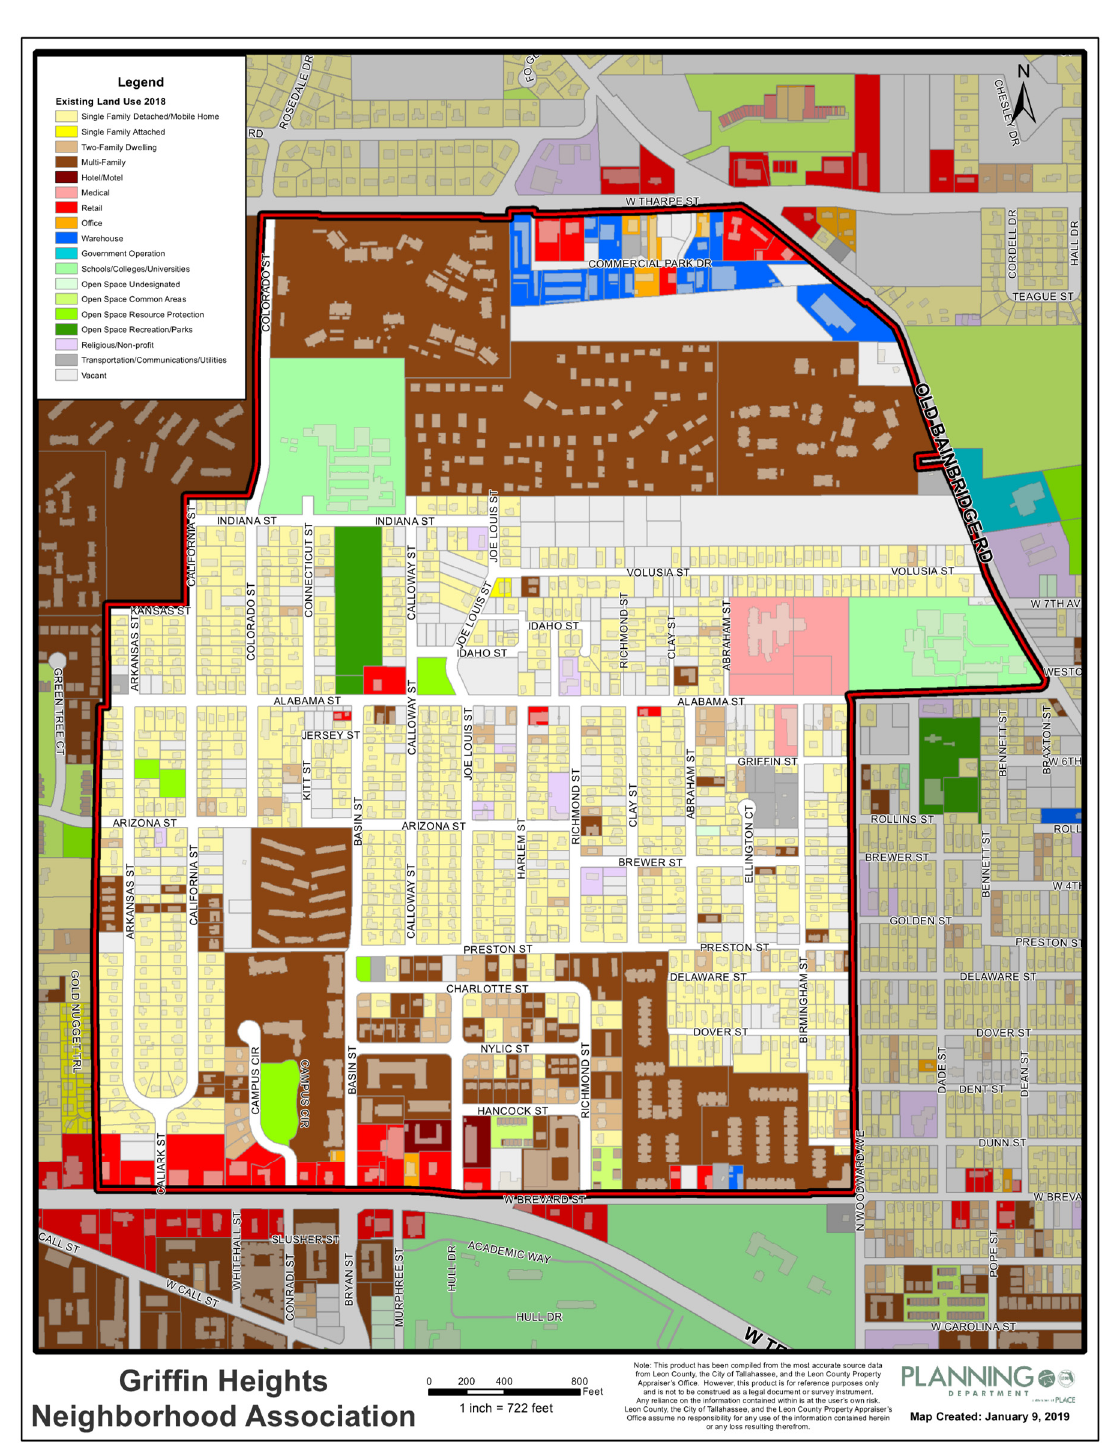
Figure 5. Land Use within Griffin Heights Neighborhood Association Boundaries (Source: City of Tallahassee).